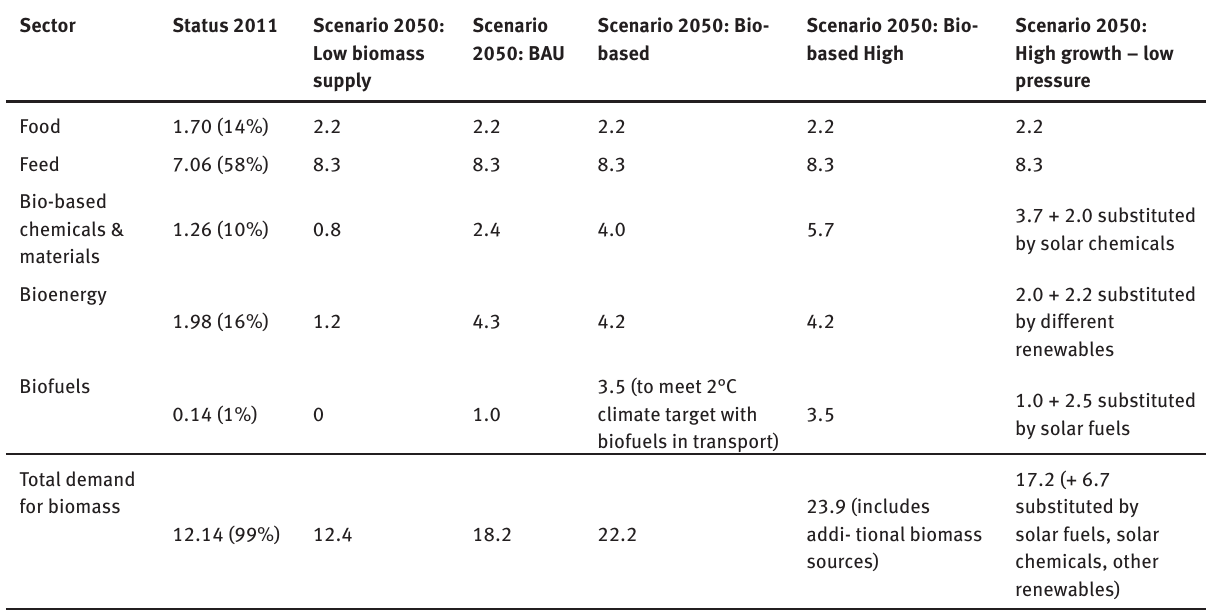
Table 2: Biomass demand of the World, 2011 and 2050, in different scenarios, in billion tonnes dry matter (based on Piotrowski et al. 2015)